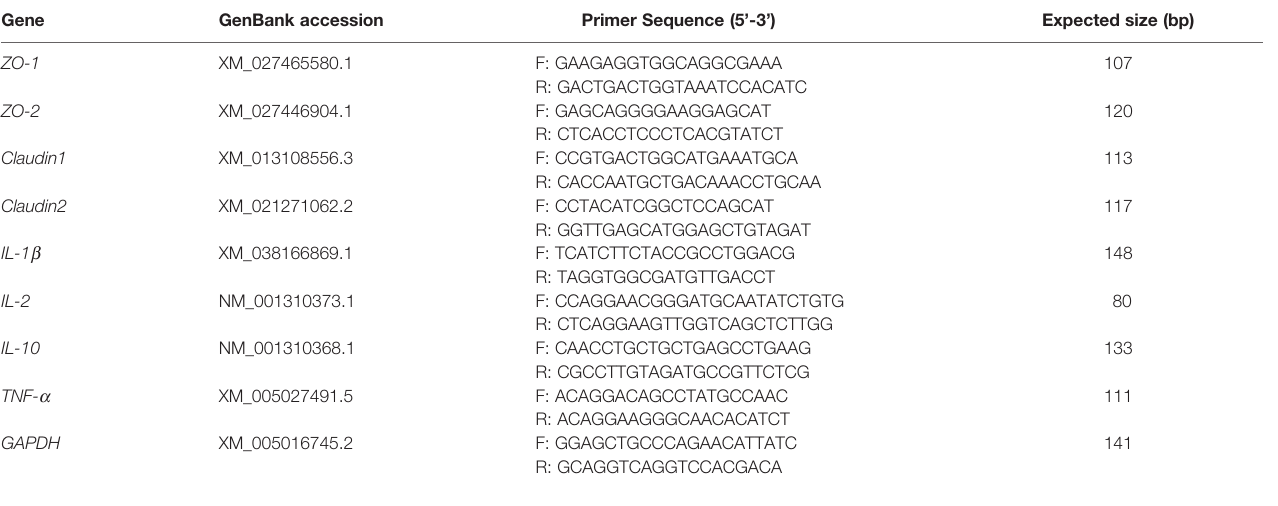
TABLE 1 | Primers for gene expression analysis using